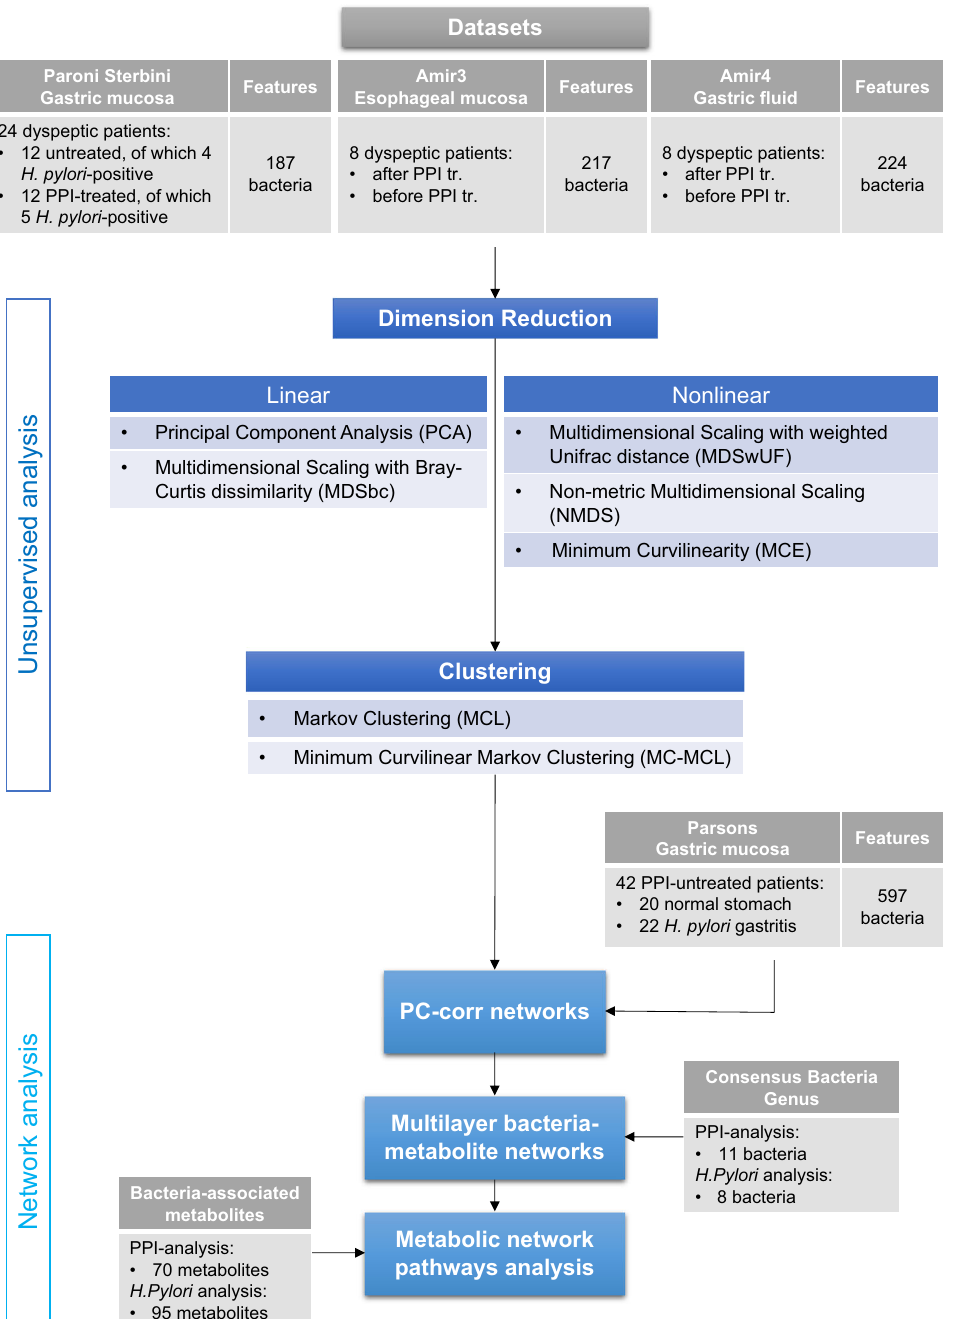
Fig. 1 Flowchart of the data analysis. To answer the fi ve questions under investigation in our study, we implemented a work fl ow based on machine learning tools. Following the fl owchart shown in the fi gure, we analysed three 16 S rRNA gene sequencing datasets with information on PPI use in dyspeptic patients; for one of the datasets (Paroni Sterbini et al. 22 ), patients were also determined to be positive or negative to H. pylori infection. First, we performed unsupervised dimension reduction, both linear and nonlinear, in the fi rst two dimensions of embedding. Nonlinear dimension reduction will show the presence of hidden patterns, in the form of sample groups. Secondly, nonlinear clustering was applied to con fi rm the well-possedeness of the hidden patterns found by nonlinear dimension reduction. Furthermore, our work fl ow ends with the network analysis. It starts with the use of the PC-corr algorithm, that reveals which combination of bacteria (features) are responsible for the identi fi ed differences between the groups of samples. A fourth dataset (Parsons et al. 29 ) is used only for the validation of the PC-corr network results and it contains information of PPI treatment and H. pylori infection. From the consensus bacteria found in each PC-corr network, a bacteria-metabolite multilayer analysis that lastly end with the metabolite pathway enrichment analysis that introduces evidence to possible perturbed biological